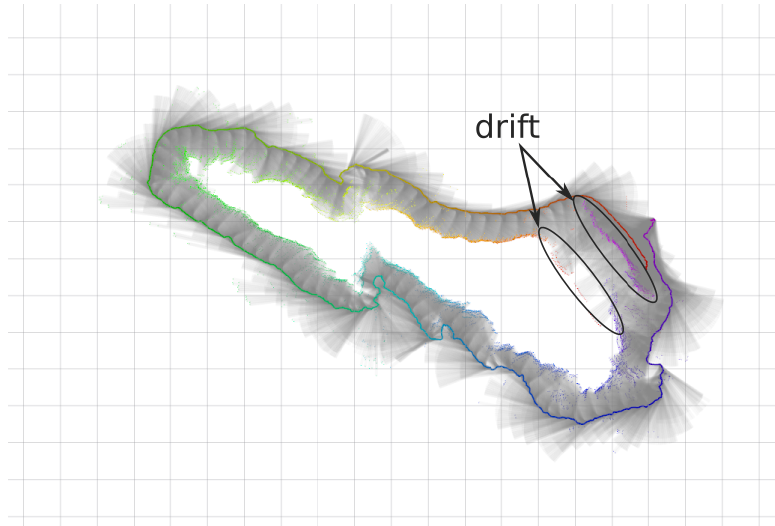
Figure 10. DR trajectory in a continuous line from magenta to red, with the corresponding profiler rays (in black) and their hitpoints (also colored by time) of the rocks dataset. Grid cells at the background are 5 m wide.